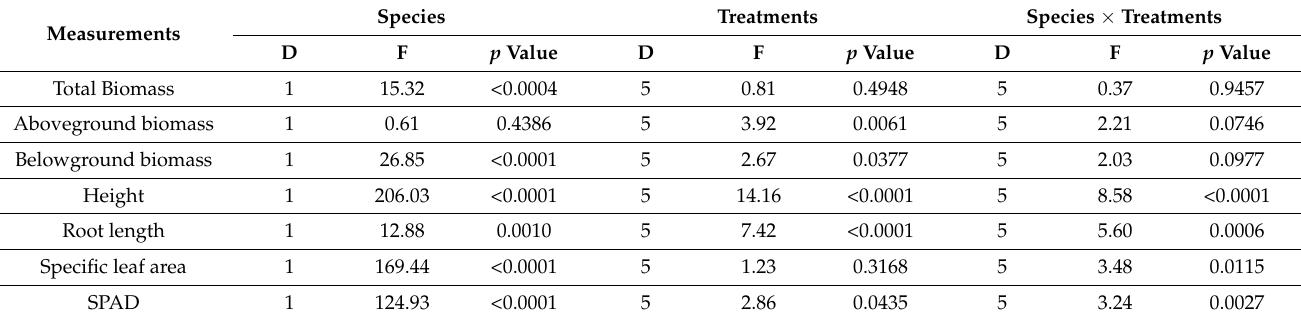
Table 1. Two-Way ANOVA between species and